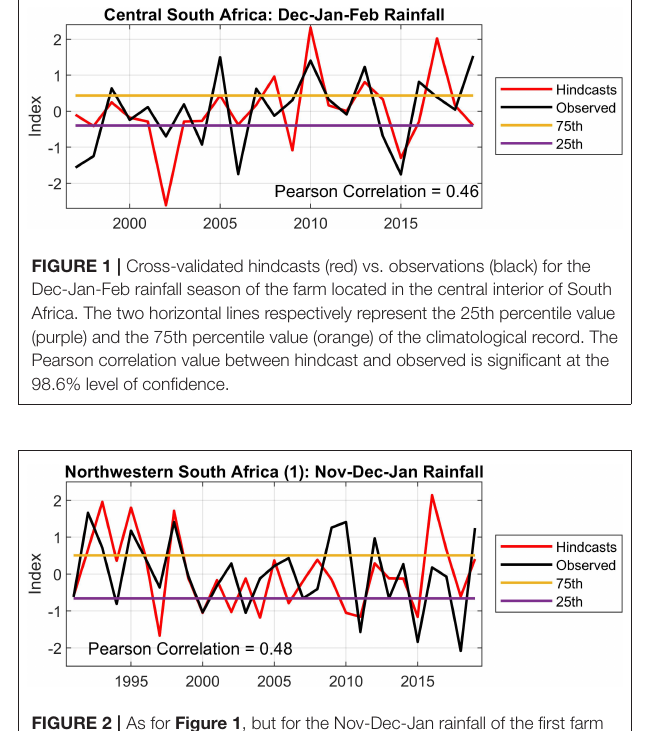
FIGURE 2 | As for Figure 1 , but for the Nov-Dec-Jan rainfall of the first farm located in the northwestern interior of South Africa. The correlation value’s level of confidence is at the 99.8% level.